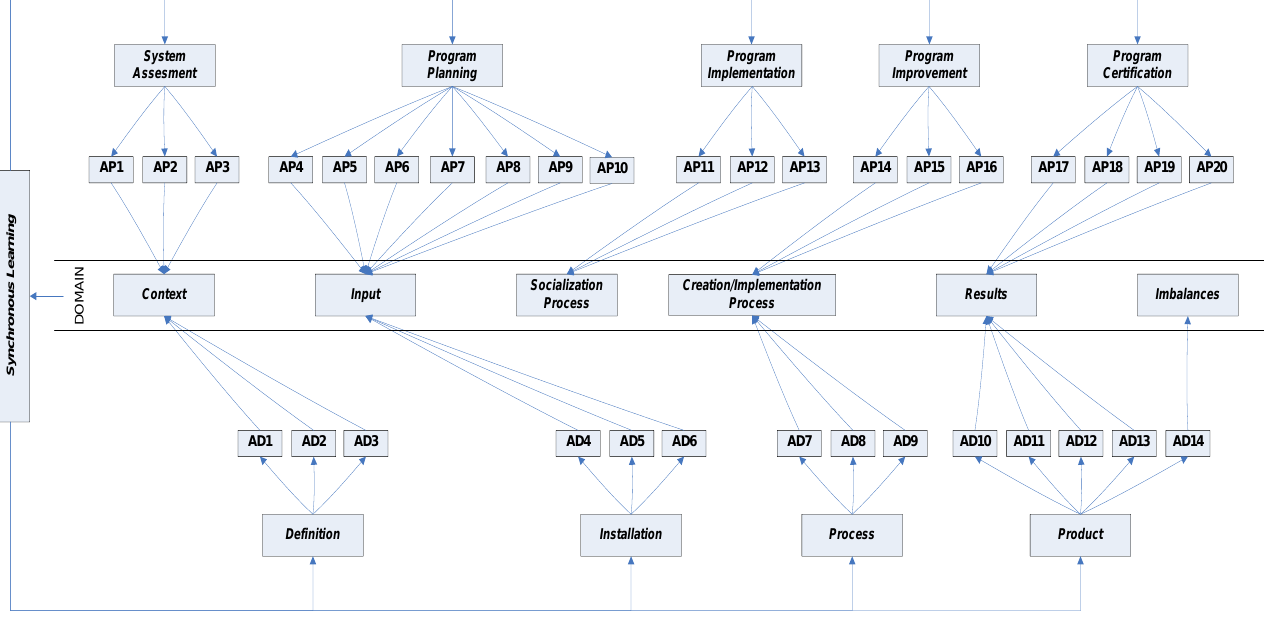
Figure 3. The Design that Modified Results of the CSE-UCLA Model and the Discrepancy Model to Evaluate the Effectiveness of Synchronous Learning at Vocational